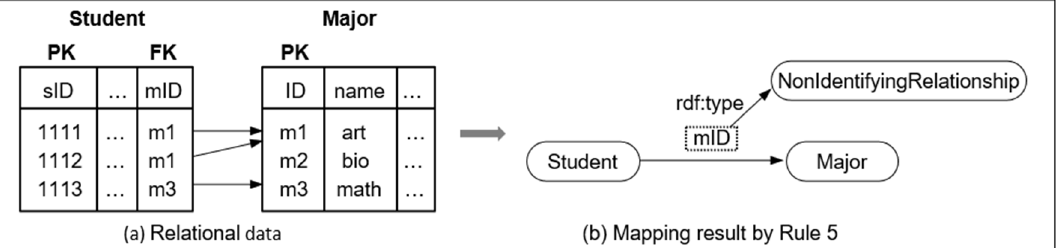
Figure 14. An example of mapping a nonidentifying relationship (Rule 5).